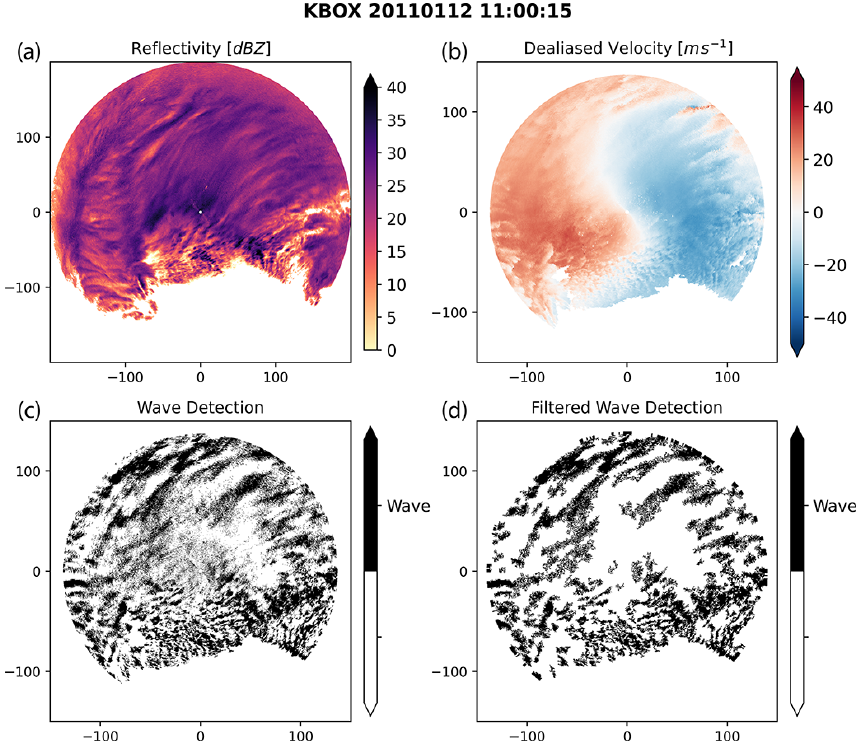
Figure 1. Bands of locally enhanced reflectivity and coincident velocity waves from Boston, MA, WSR-88D radar (KBOX) on 12 Jan- uary 2011 at 11:00UTC. Data shown are 0.5 ◦ elevation angle PPIs. (a) Radar reflectivity, (b) dealiased radial velocity, (c) binary version of the difference field between consecutive radial velocity fields, all in polar coordinates, and (d) Cartesian coordinate (0.5km grid spacing) filtered version of (c) with eight-connected areas < 16km 2 removed. An animated version of this figure is in Video Supplement Animation-